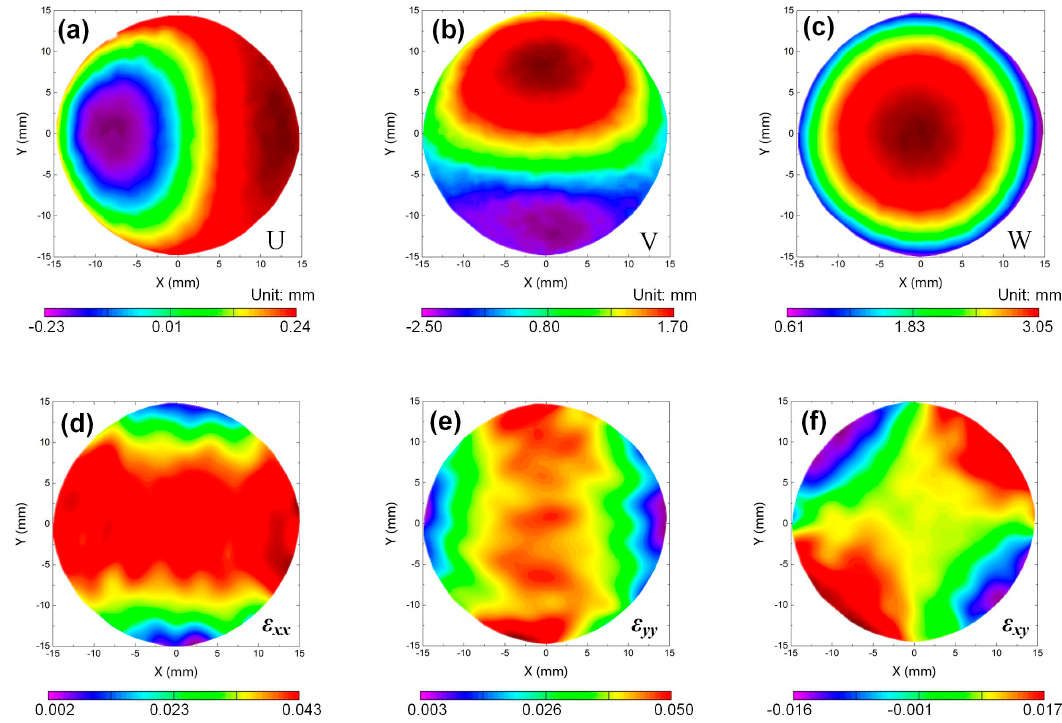
Figure 9. Experimental results of the centrally loaded circular plate ( a ) U-displacement field, ( b ) V-displacement field, ( c ) W-displacement field, ( d ) ε xx -strain field, ( e ) ε yy -strain field, and ( f ) ε xy -strain field.